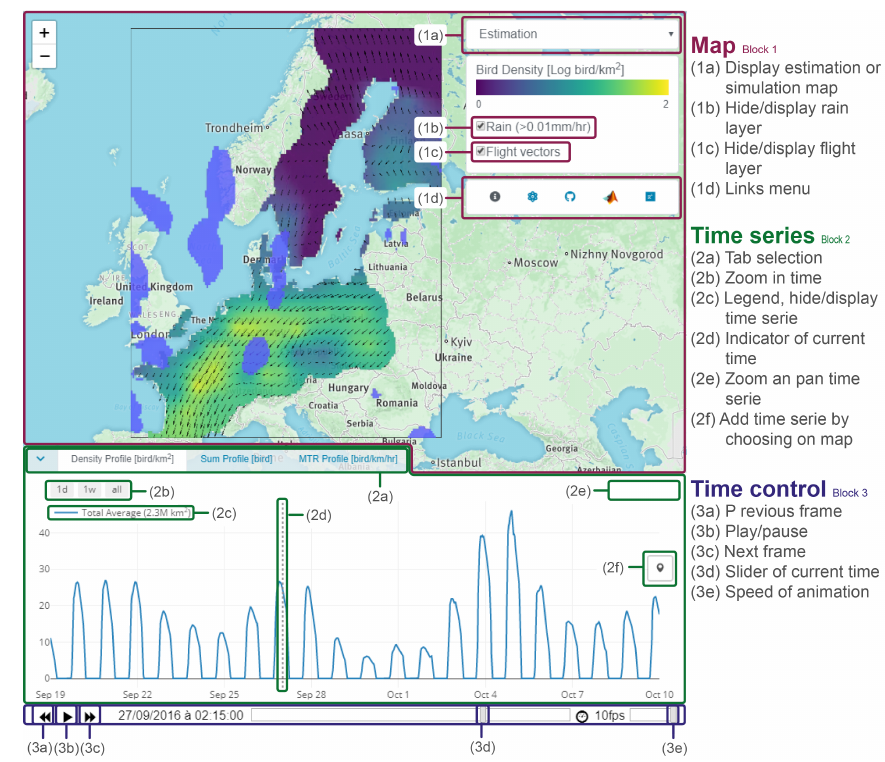
Figure A9. Illustration of the website interface with annotations for each interactive